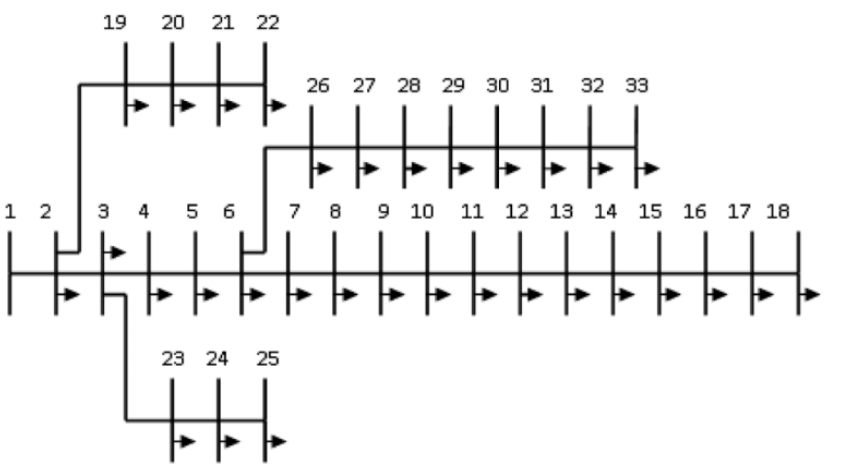
Figure 2. IEEE 33 bus system used for